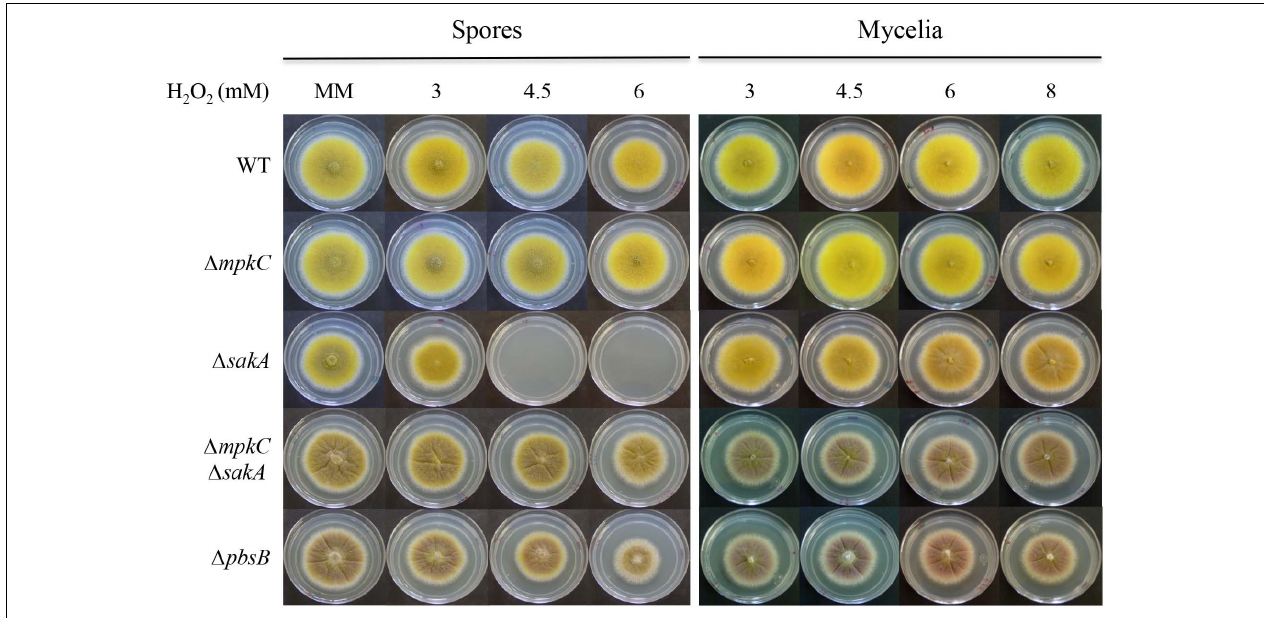
FIGURE 3 | SakA and MpkC regulate conidia oxidative stress resistance in opposite ways. Conidia (1 × 10 4 ) or mycelial plugs cut from the growing edge of 5-day colonies from strains CLK43 (WT), COS0020 (cid:49) mpkC ( (cid:49) mpkC ), CRJ1 ( (cid:49) sakA ), CRJ11 ( (cid:49) mpkC (cid:49) sakA ), and COS (cid:49) pbsB05 ( (cid:49) pbsB ) were used to inoculate supplemented MM plates containing H 2 O 2 at the indicated concentrations, and incubated at 37 ◦ C for 4 days.